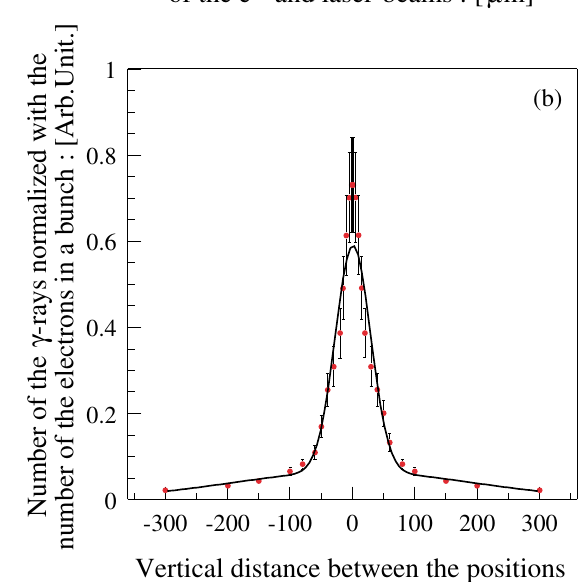
Vertical distance between the positions FIG. 19. (Color) Result of the position scan calculated by the (cid:2) numerical model: (a) for the horizontal direction, # M x (cid:2) 28 (cid:6) m 29 (cid:6) m ; (b) for the vertical direction, # M y